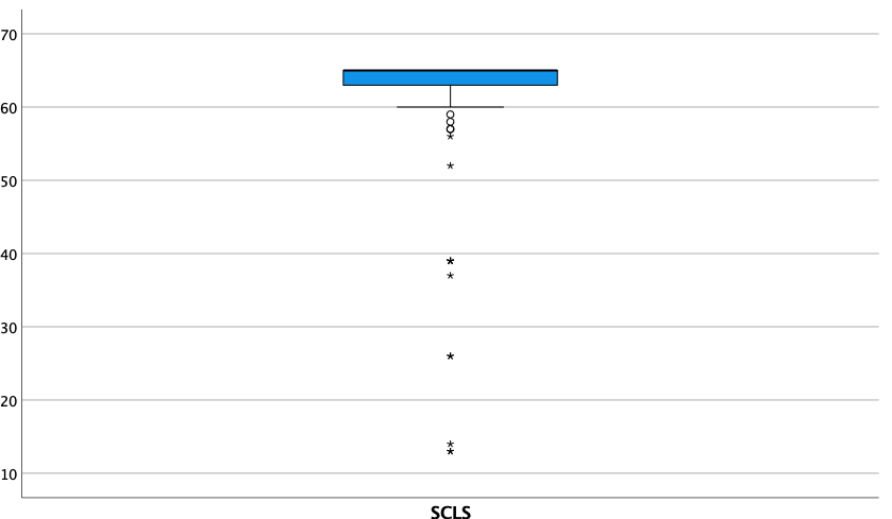
Figure 1. SCLS score boxplot. The asterisks mean abnormally far values (distance on the median greater than 3 interquartile ranges).